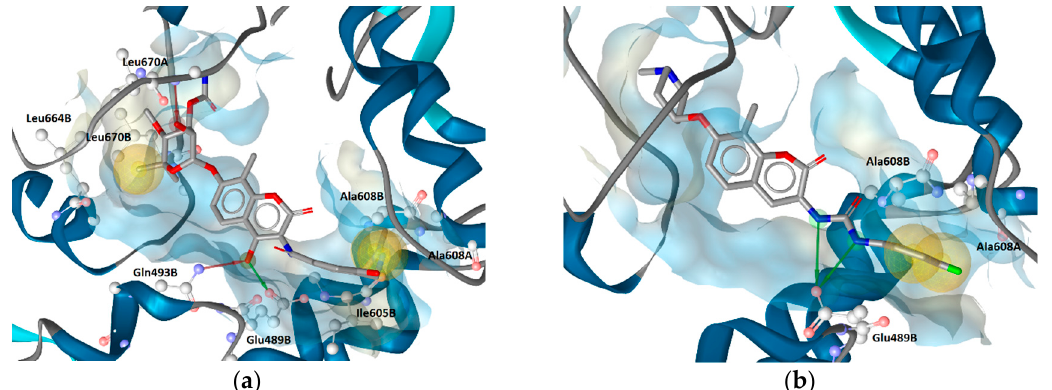
Figure 7. Chemical feature-based pharmacophore features of the most frequently occurring interactions and binding modes of ( a ) novobiocin (yellow) and ( b ) compound 2 derived from 20 ns MD simulations with the Hsp90 β C-terminal domain (5FWK). For clarity, only amino acids interacting with the respective ligands are shown. A hydrophobic feature is shown as yellow sphere, H-bond donor as green arrow and H-bond acceptor as red arrow, indicating a defined direction for H-bonding.